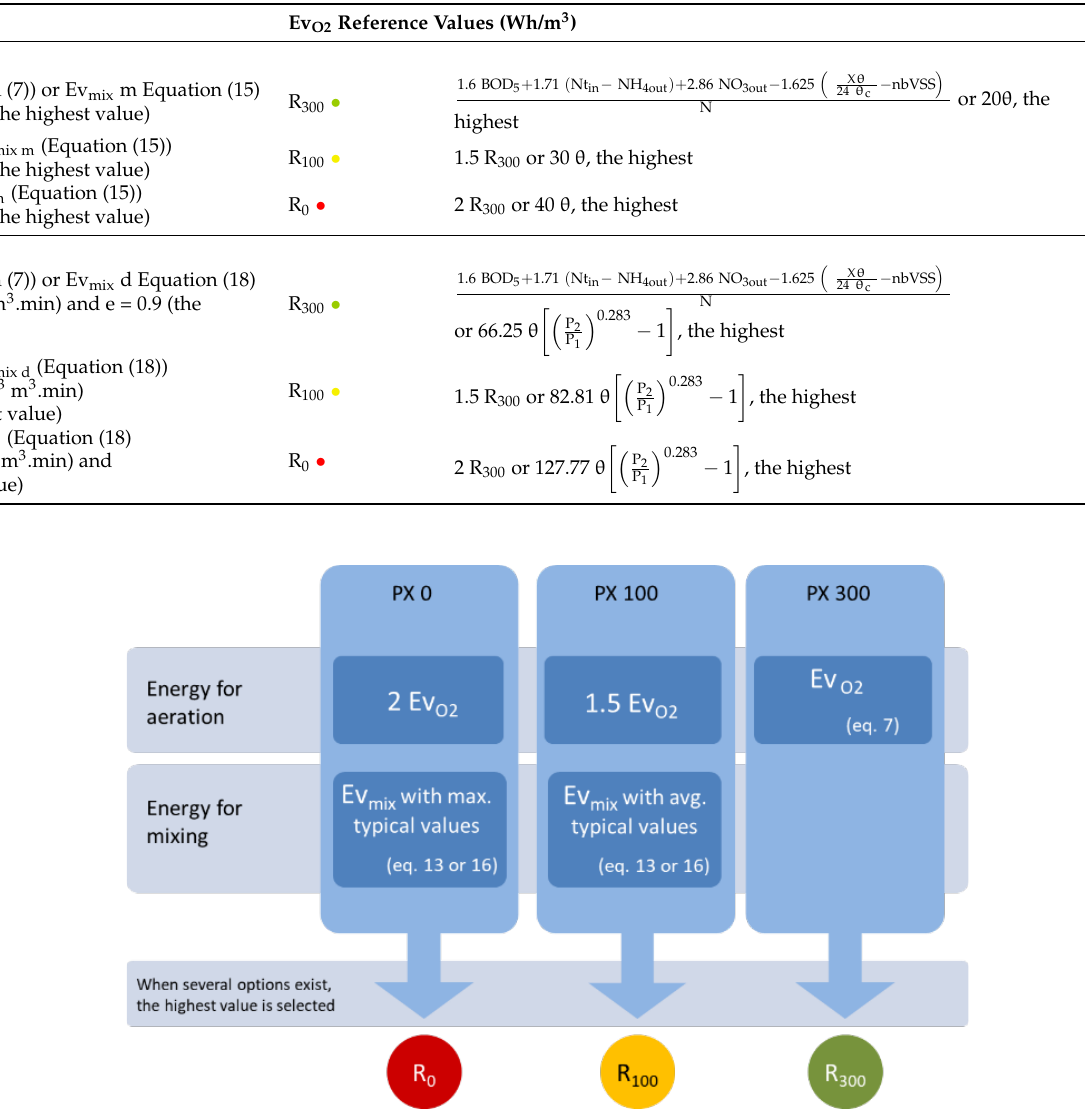
Table 1. The reference values of energy consumption for aeration in AS systems.